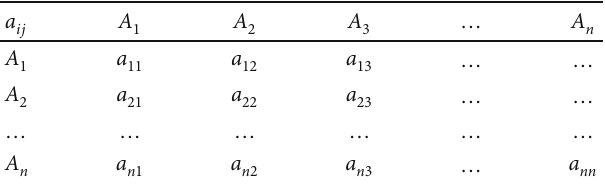
Table 2: Assignment of judgment matrix A . a ij